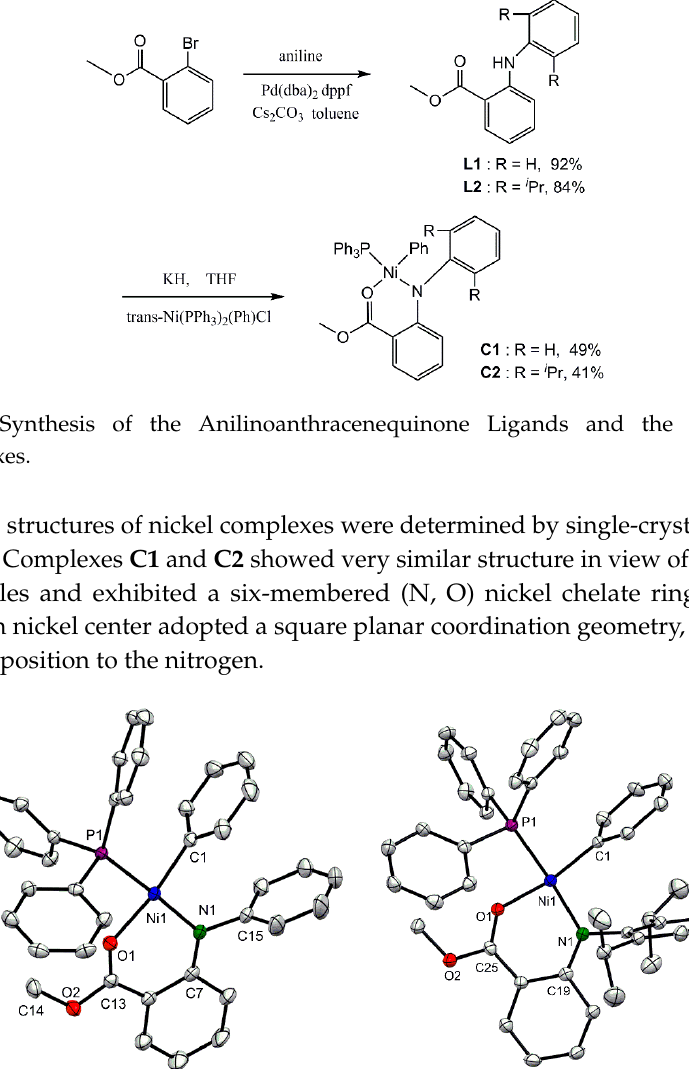
Figure 1 . Molecular structures of complexes C1 and C2 . H atoms are omitted for clarity. Selected bond lengths (Å) and angles (deg) for C1 : Ni1-N1 = 1.9223 (14), Ni-C1 = 1.8841 (17), Ni1-O1 = 1.9180 (12), Ni1-P1 = 2.1758 (5), O1-Ni1-N1 = 91.14 (6), C1-Ni1-P1 = 87.12 (5); C2 : Ni1-N1 = 1.932 (2), Ni-C1 = 1.891 (2), Ni1-O1 = 1.9193 (17), Ni1-P1 = 2.1816 (7), O1-Ni1-N1 = 91.33 (8), C1-Ni1-P1 = 86.59